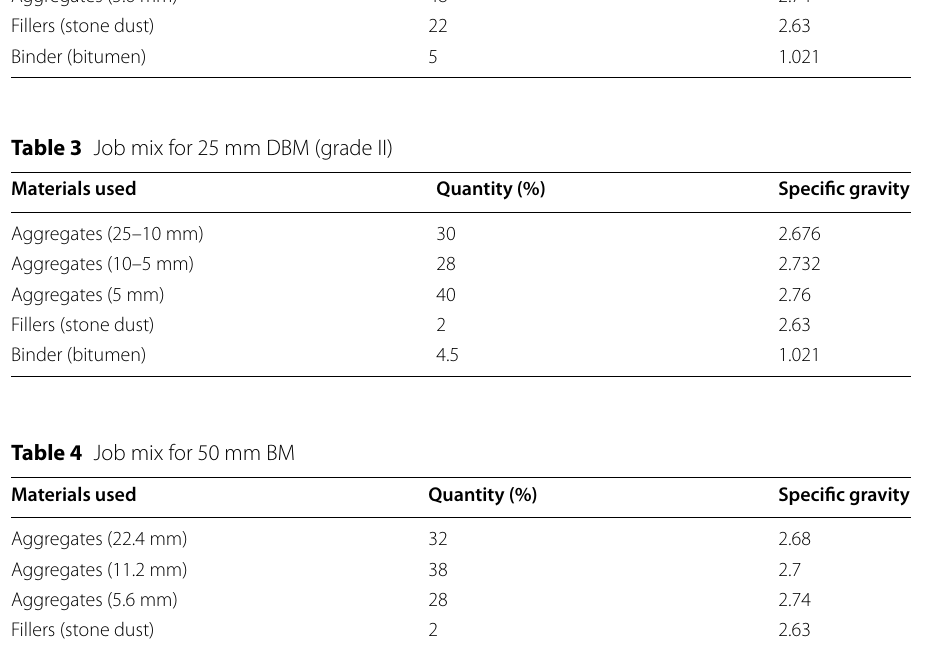
Table 2 Job mix for 25 mm SDBC (grade II) Materials used Quantity (%) Specific gravity Aggregates (11.2 mm)